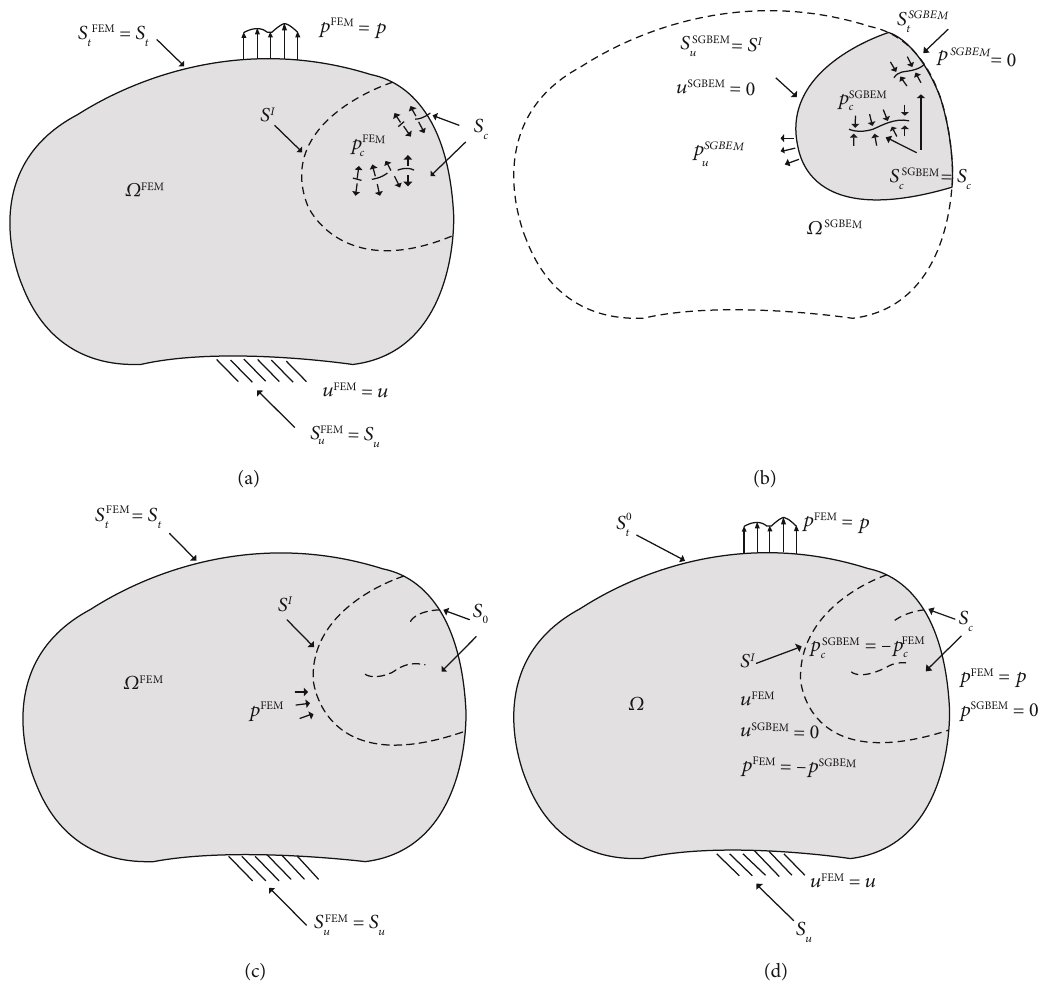
Figure 3: Superposition principle for SGBEM-FEM Alternating Method: (a) the uncracked global structure modeled by simple FEM; (b) the cracked local subdomain modeled by SGBEM; (c) the FEM model subjected to residual stresses; (d) alternating solution for the original problem.